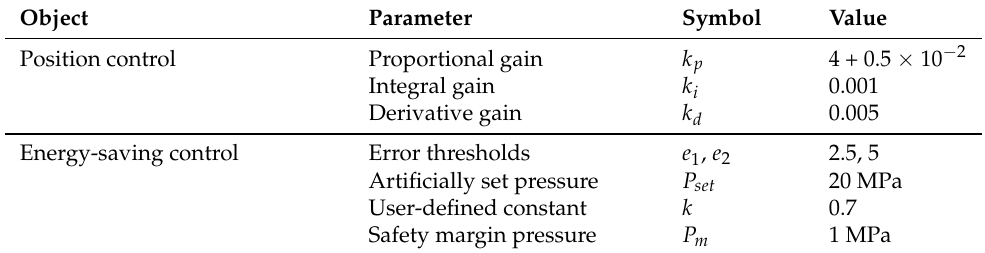
Table 1. Control